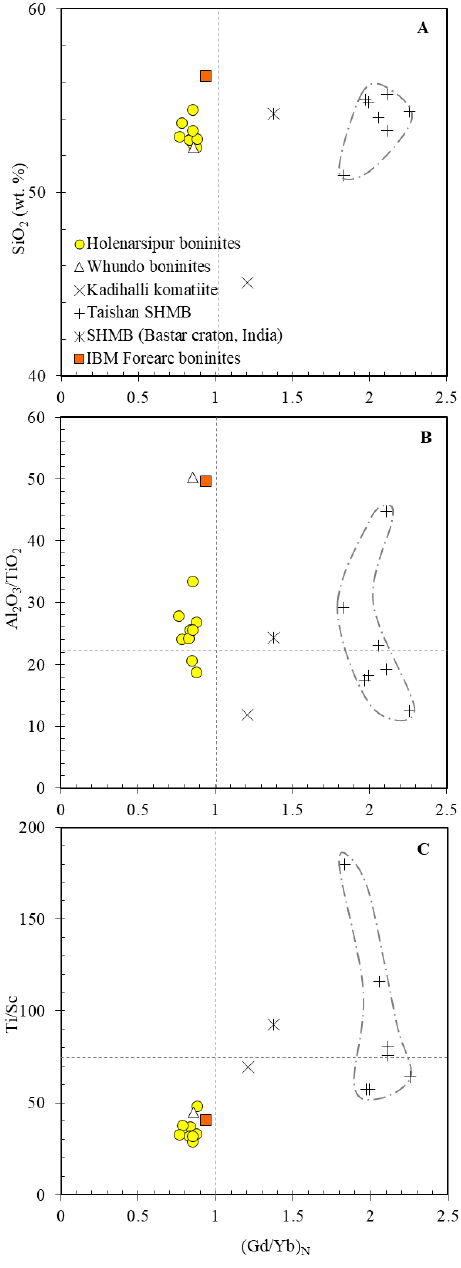
Figure 9. Chondrite normalized (Gd/Yb) ratio vs. ( A ) SiO 2 ; ( B ) Al 2 O 3 /TiO 2 ; and, ( C ) Ti/Sc bivariate diagrams to discriminate between the boninites, and komatiites and siliceous high-Mg basalts. Stippled lines are chondrite values [17]. Data sources as in Figure 5. See text for details.